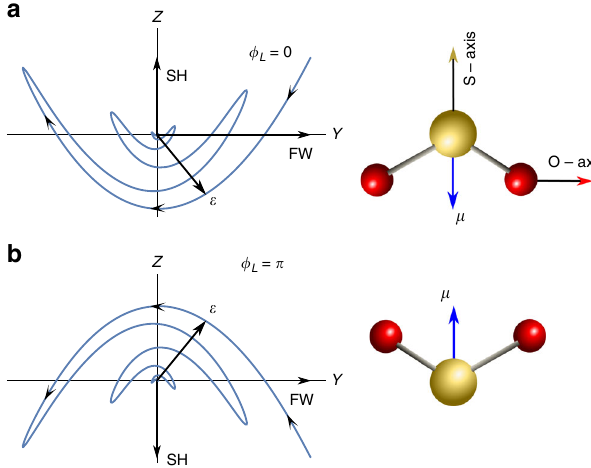
Fig. 6 Orientation geometry for two phases. Schematic representation of trajectory of the OTC fi eld vector, E for a ϕ L = 0 and b ϕ L = π . In both cases, SO 2 molecule is shown in the orientation providing the maximal ionization. Blue arrows denote the molecular permanent dipole,